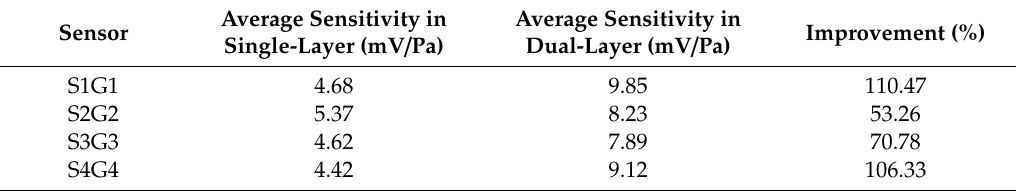
Table 2. The average sensitivities of the single-layer and dual-layer hot film sensors with the flow shear stress varying from 0 to 30 Pa.